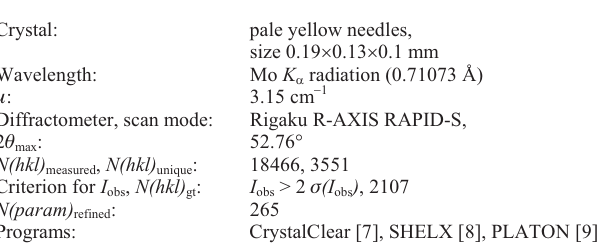
Table 1. Data collection and